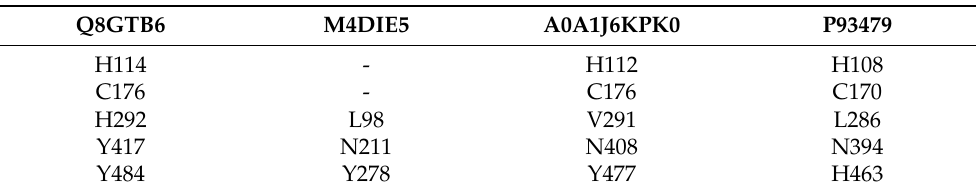
Table 3. Critical residues in THCA synthase (Q8GTB6) with the corresponding analogous residues in the orthologues. The proteins are identified by their UNIPROT ID. Residues are labelled using the single letter amino acid code.